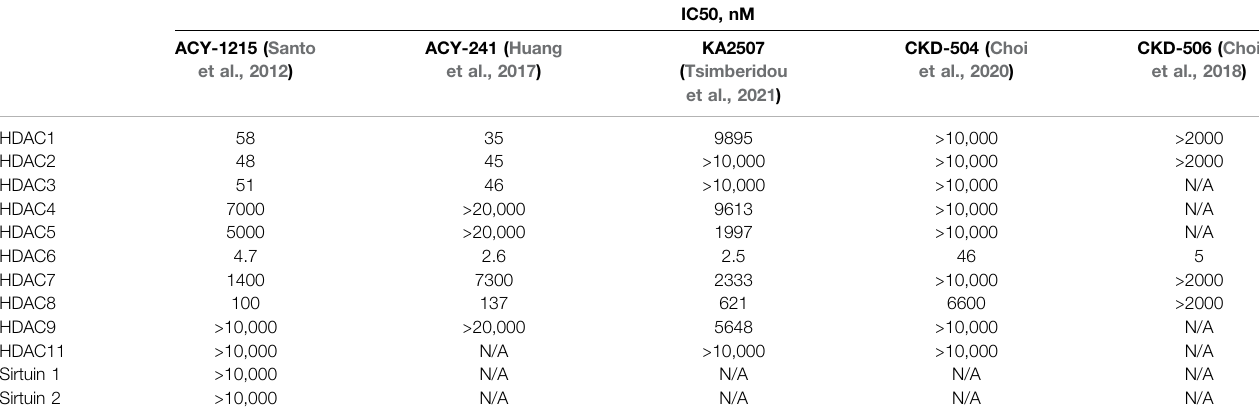
TABLE 3 | Inhibition of HDAC6 inhibitors on